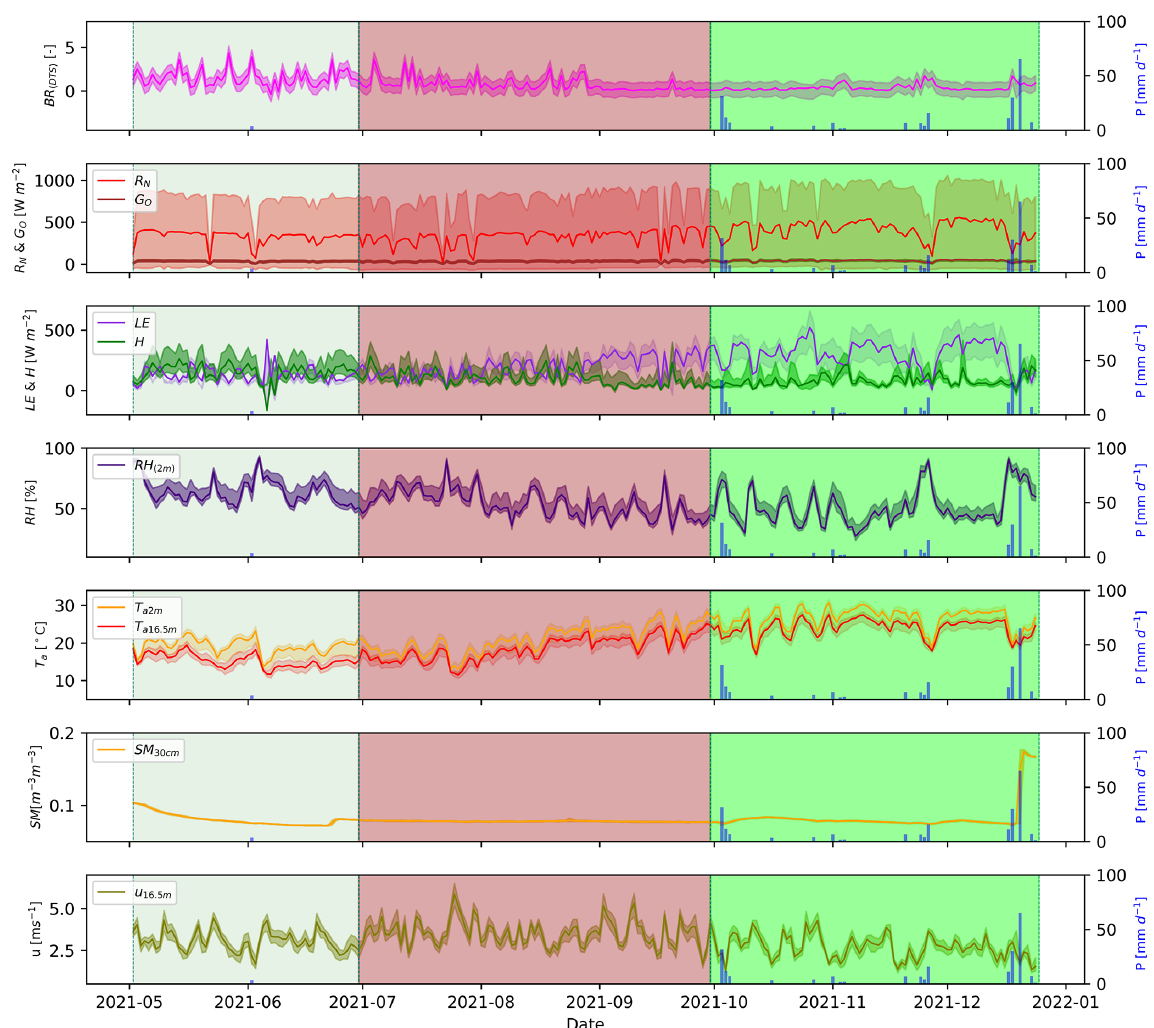
Figure 6. Daily diurnal meteorological conditions at the Mpika study site in the Luangwa Basin for the period May 2021–December 2021. Shaded area for variables is the standard deviation. Shaded area for May–June is the canopy green-down phenophase, July–September is the dormant phenophase, and October–December is the green-up